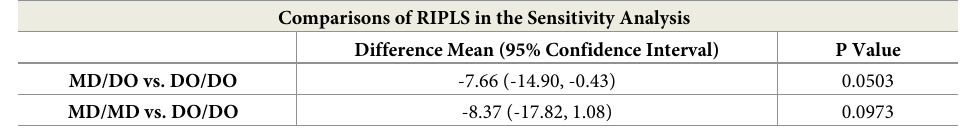
Table 2. Comparisons of RIPLS in the sensitivity